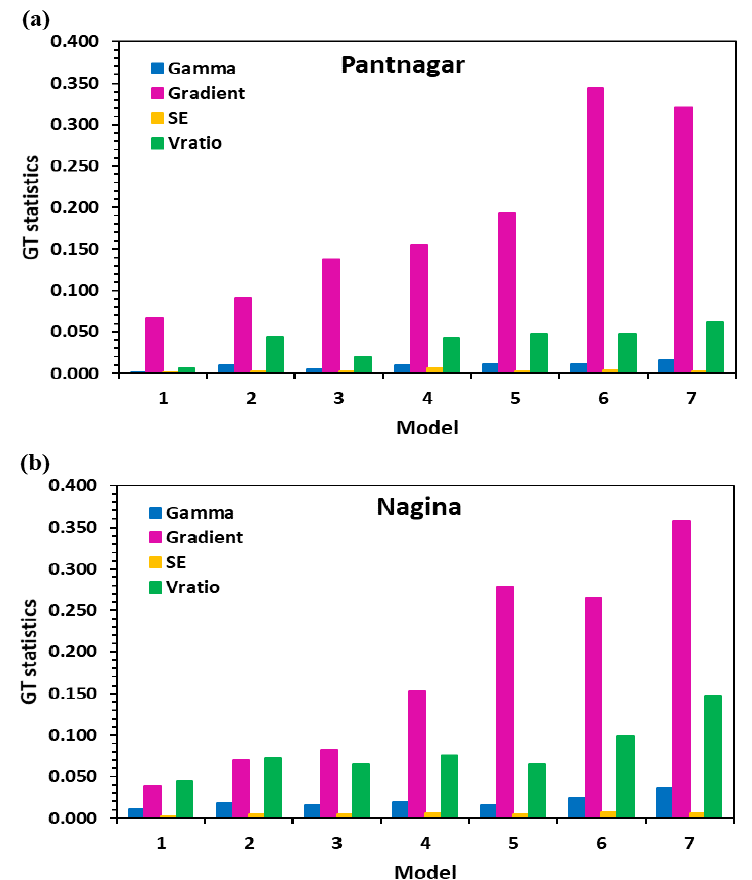
ff erent models at ( a ) Pantnagar and ( b ) Nagina Figure 6. GT statistics of different models at (a) Pantnagar and ( b ) Nagina stations. Figure 6. GT statistics of di